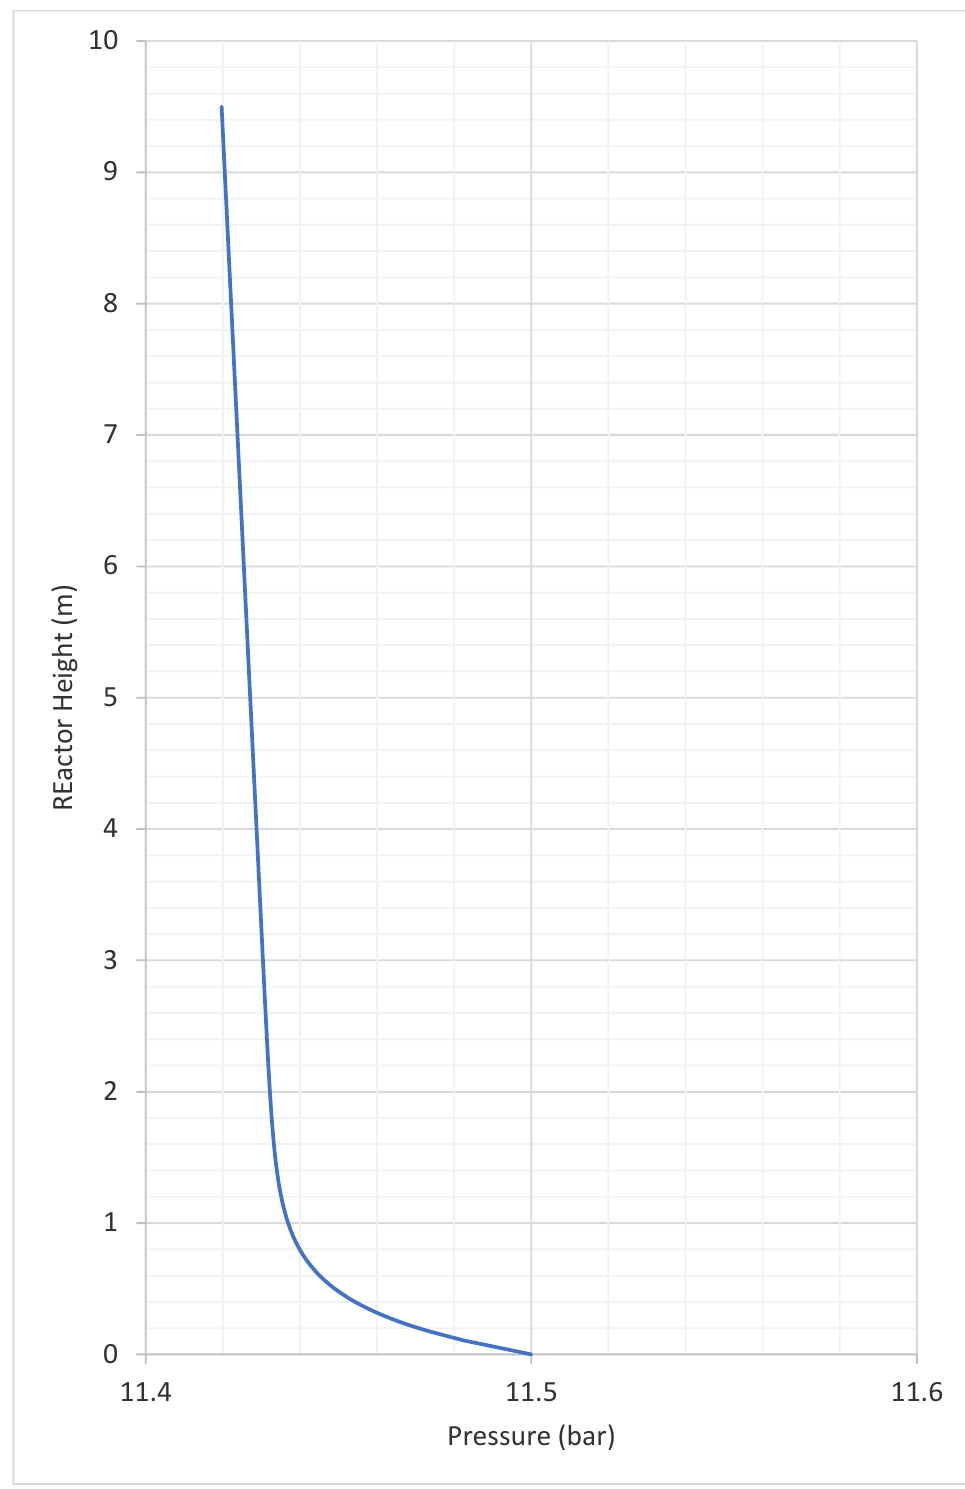
Figure 7. Pressure trend in the air reactor [64].